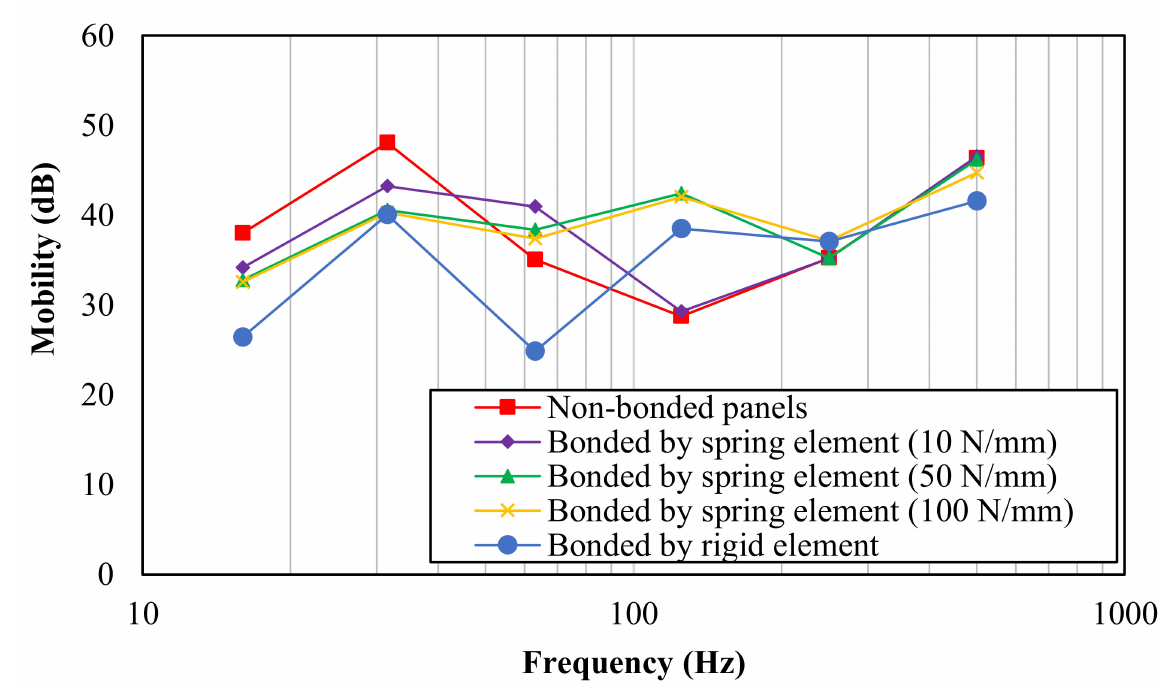
Figure 13. Results of octave band analysis of numerical result by the FEM in the present